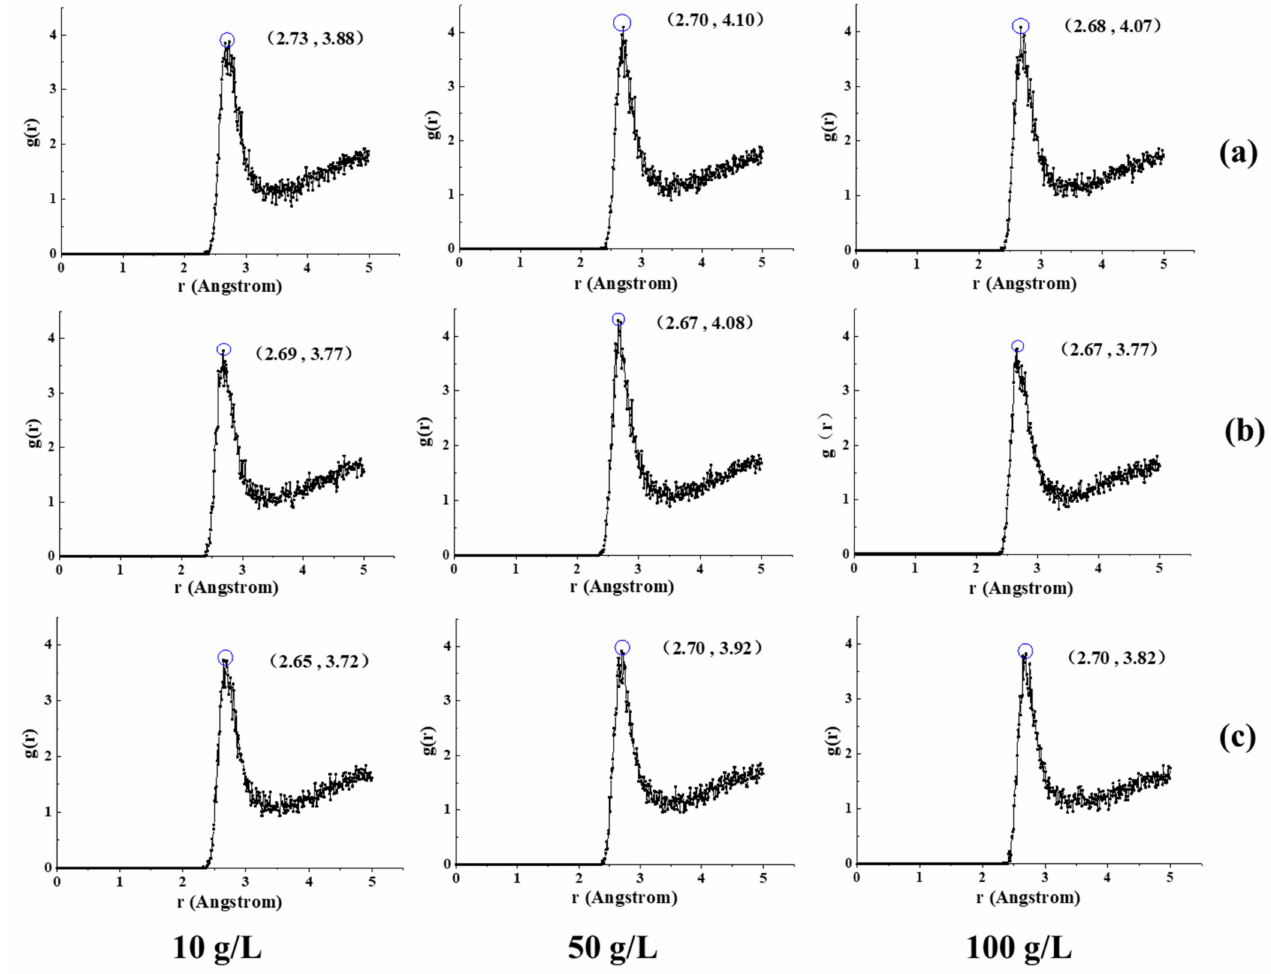
Figure 11. RDF of APG head groups and water molecules in foams with different concentrations of cation. ( a ) CaCl 2 , ( b ) MgCl 2 , and ( c )